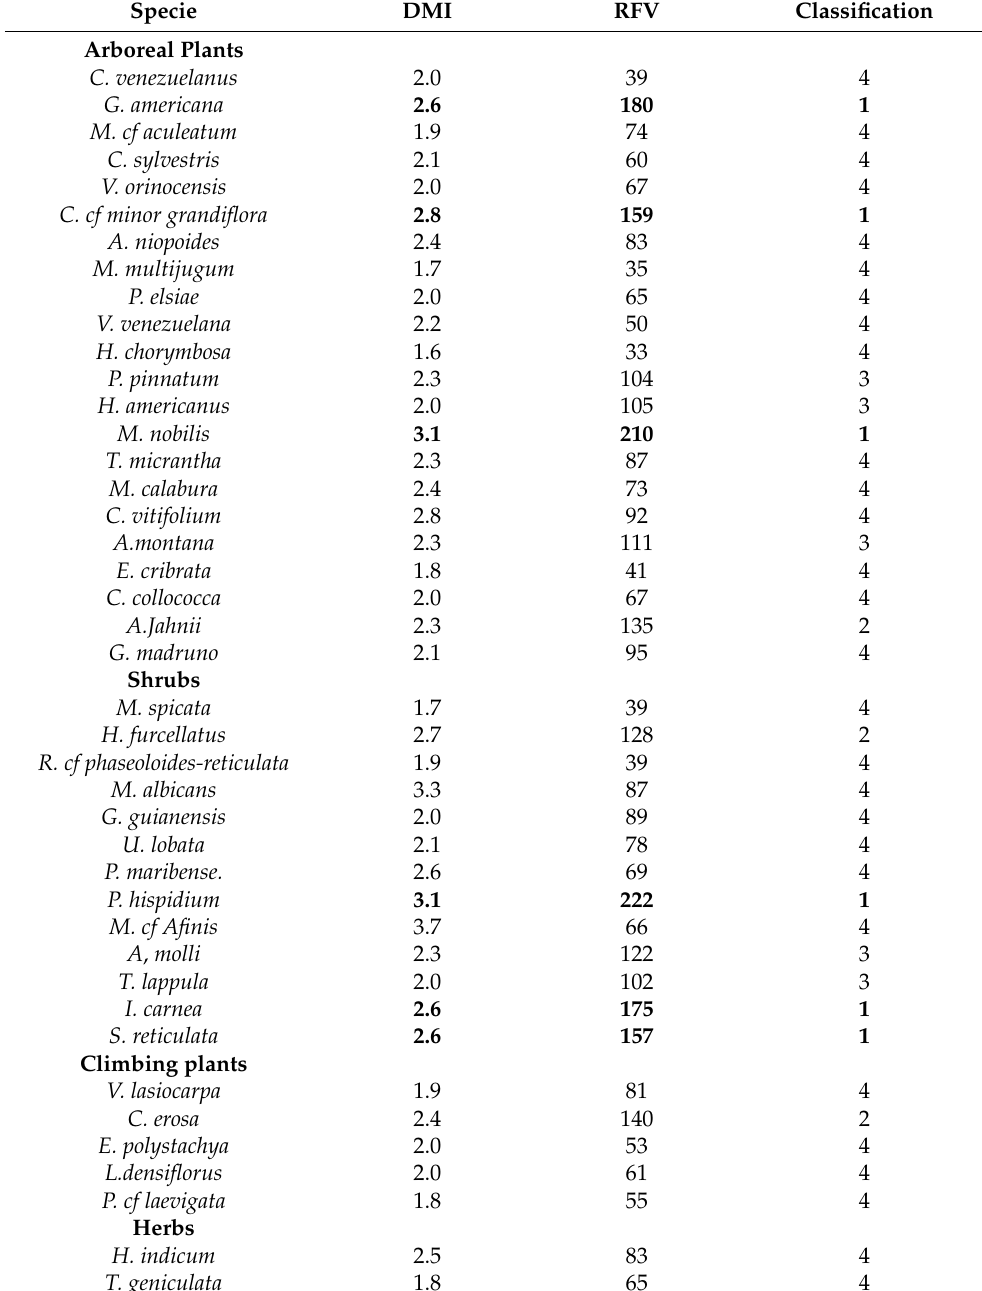
Table 4. Estimated dry matter intake and relative feed values of the evaluated